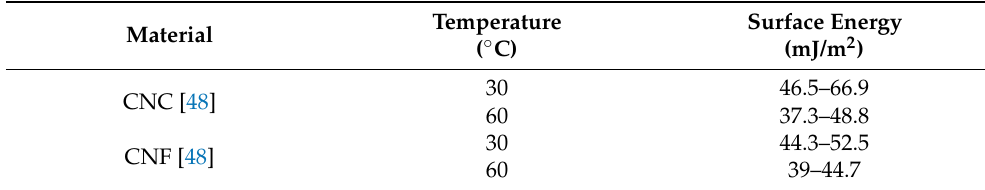
Table 4. Surface energy for different materials at different temperatures.